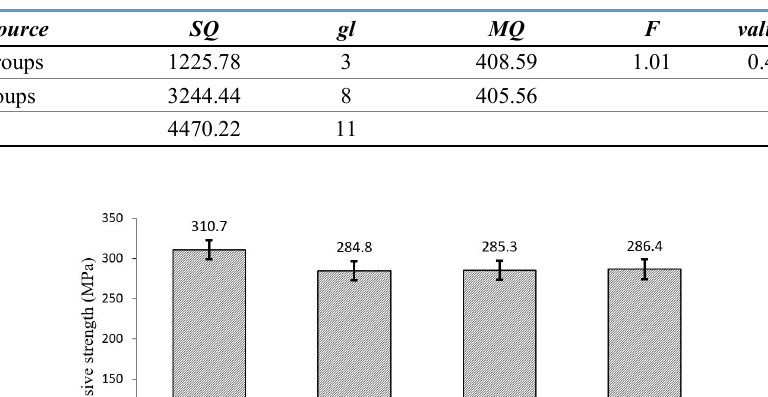
Table 7. ANOVA Phase 3 – influence of the type of pigment in concrete strength